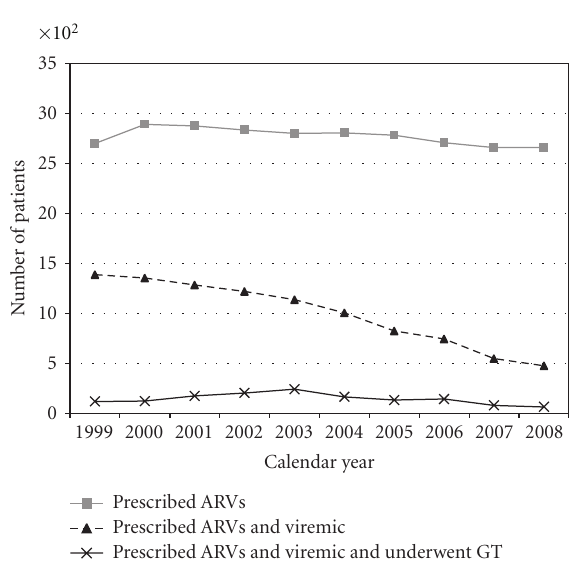
Figure 1: Number of patients who underwent genotypic testing (GT) while prescribed antiretrovirals (ARVs) and viremic (HIV viral load > 1,000 copies/mL), the HIV Outpatient Study, 1999– 2008.